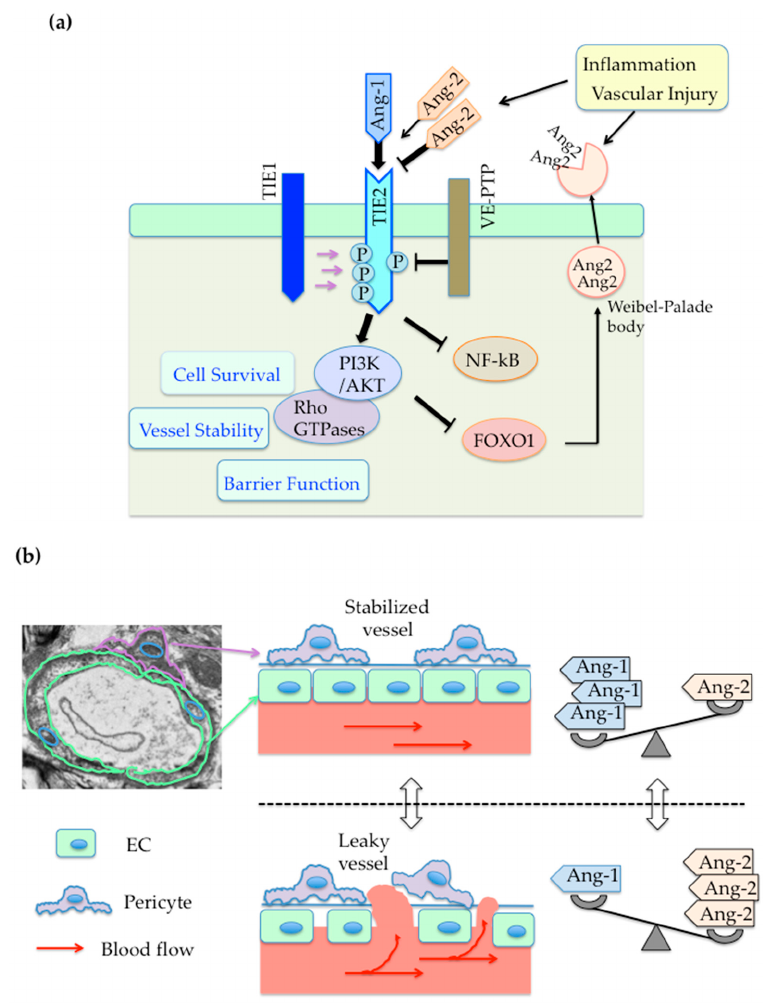
Figure 2. Angiopoietin–TIE signaling pathway in the vascular endothelium. ( a ) The schema indicates Ang-TIE signaling in vascular ECs. Ang1 promotes endothelial cell survival, vessel stability and barrier function via activation of signaling receptor TIE2 and its downstream targets, PI3K/AKT and Rho family GTPases. Ang1-TIE2-PI3K/AKT signaling inhibits NF-kB, FOXO 1 and FOXO 1-induced Ang2. Ang2 is a weak agonist or antagonist which modulates Ang1-TIE2 pathway. Upon inflammation and vascular injury, Ang2, stored in Weibel-Palade bodies, are released in circulation, antagonizes Ang1-TIE2 signaling and then increases FOXO1 and Ang2. Unlike signaling receptor TIE2, TIE1 is an orphan receptor homolog of TIE2, and mostly does not react to ligands. In some cases, TIE2 signaling is stimulated by phosphorylation due in part to the TIE receptor complex with TIE1. TIE2 activation is also achieved by the inhibition of a VE-PTP, which dephosphorylates and deactivates TIE2. Note that ‘P’ next to the intracellular part of TIE2 indicates phosphorylation. ( b ) The left upper panel shows transmission EM images with schematic indication of vascular ECs and pericytes. The right upper panel indicates that abundant Ang1 enhances endothelial barrier function and stabilizes vessels. In contrast, abundant Ang2 decreases endothelial barrier function and increases vascular permeability, leading to the formation of leaky vessels (Right lower